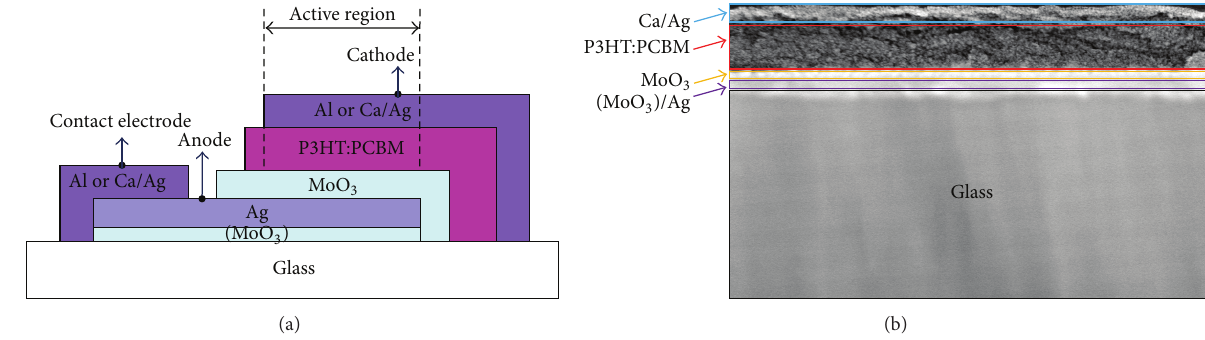
Figure 1: (a) Device geometry of ITO-free reference or ITO-free semitransparent OSCs based on (MoO 3 )/Ag anodes and (b) TEM cross- sectional image of ITO-free semitransparent OSCs.